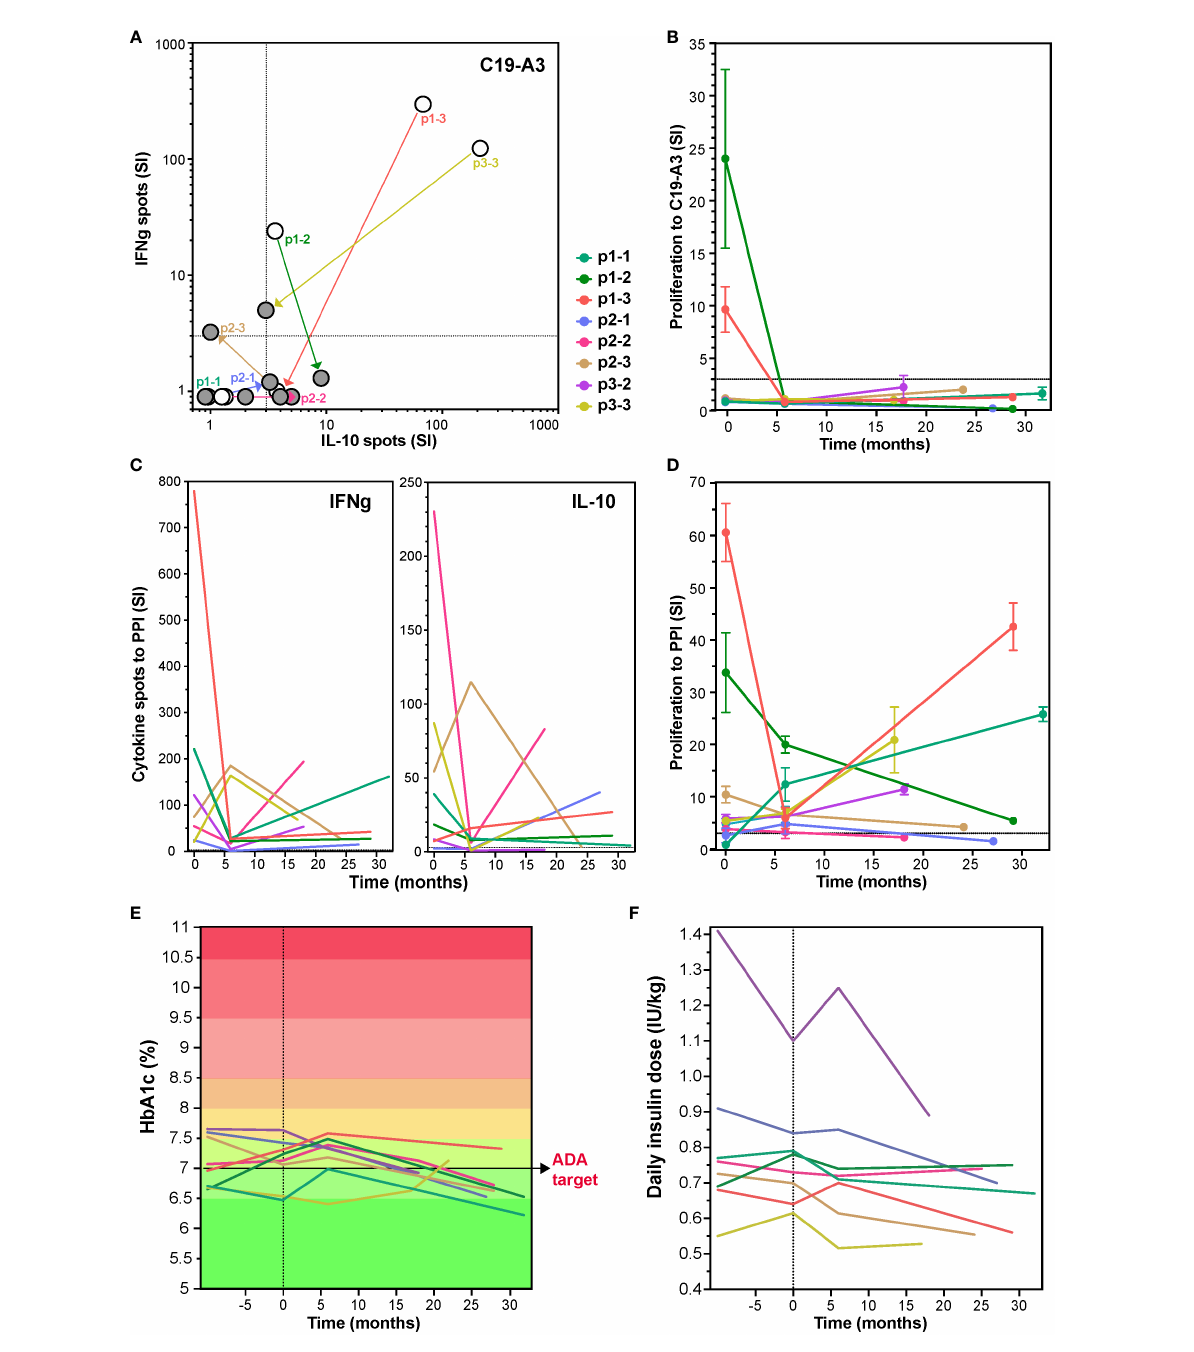
FIGURE 3 Change in T-cell responses to C19-A3 vaccine peptide, preproinsulin (PPI) and glycemia control at long term after tolDC therapy. Long-term effect of tolDC therapy on the cytokine response to C19-A3 (A) and PPI (C) . Patients reacting to C19-A3 prior to tolDC therapy, retain low response to C19-A3 at revisit and four out of eight patients show predominantly IL-10-producing response. TolDC therapy also reduced cytokine release to PPI with IFNg more strongly reduced than IL-10 in six out of eight patients at revisit (IFNg p=0.0012 and IL-10 p=0.34, paired T-test). White dots in (A) depict the cytokine spots before tolDC and fi lled dots at revisit. Patient speci fi c values are connected. (B) and (D) Proliferation to C19-A3 peptide (B) and PPI (D) at revisit compared to the values before tolDC treatment. Lines in (B) to (F) represent individual patients coded in color as depicted. Patients p1-2, p1-3 and p2-1 reduced proliferation on the long term, other patients responses remain unchanged except for patient p1-1, showing an increased proliferation to PPI compared to the timepoint before tolDC therapy. (E) and (F) show change in HbA1c and insulin use in